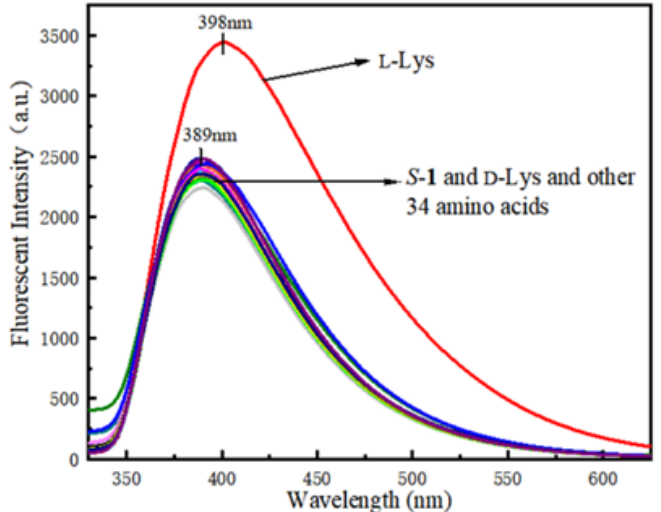
Figure 6. Fluorescence spectra of S - 1 (2.0 × 10 − 5 M in CH 3 OH) with different enantiomers of 18 ordinary amino acids (20.0 equivalents) ( λ ex = 318 nm, slits = 5.0/2.5 nm).